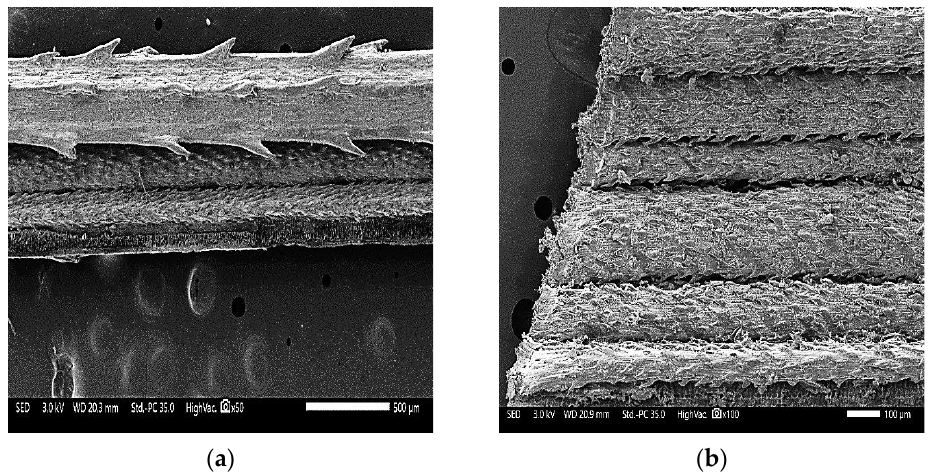
Figure 3. Observation by scanning electron microscope: longitudinal section, ( a ) exterior and ( b ) interior of the Diss fiber.